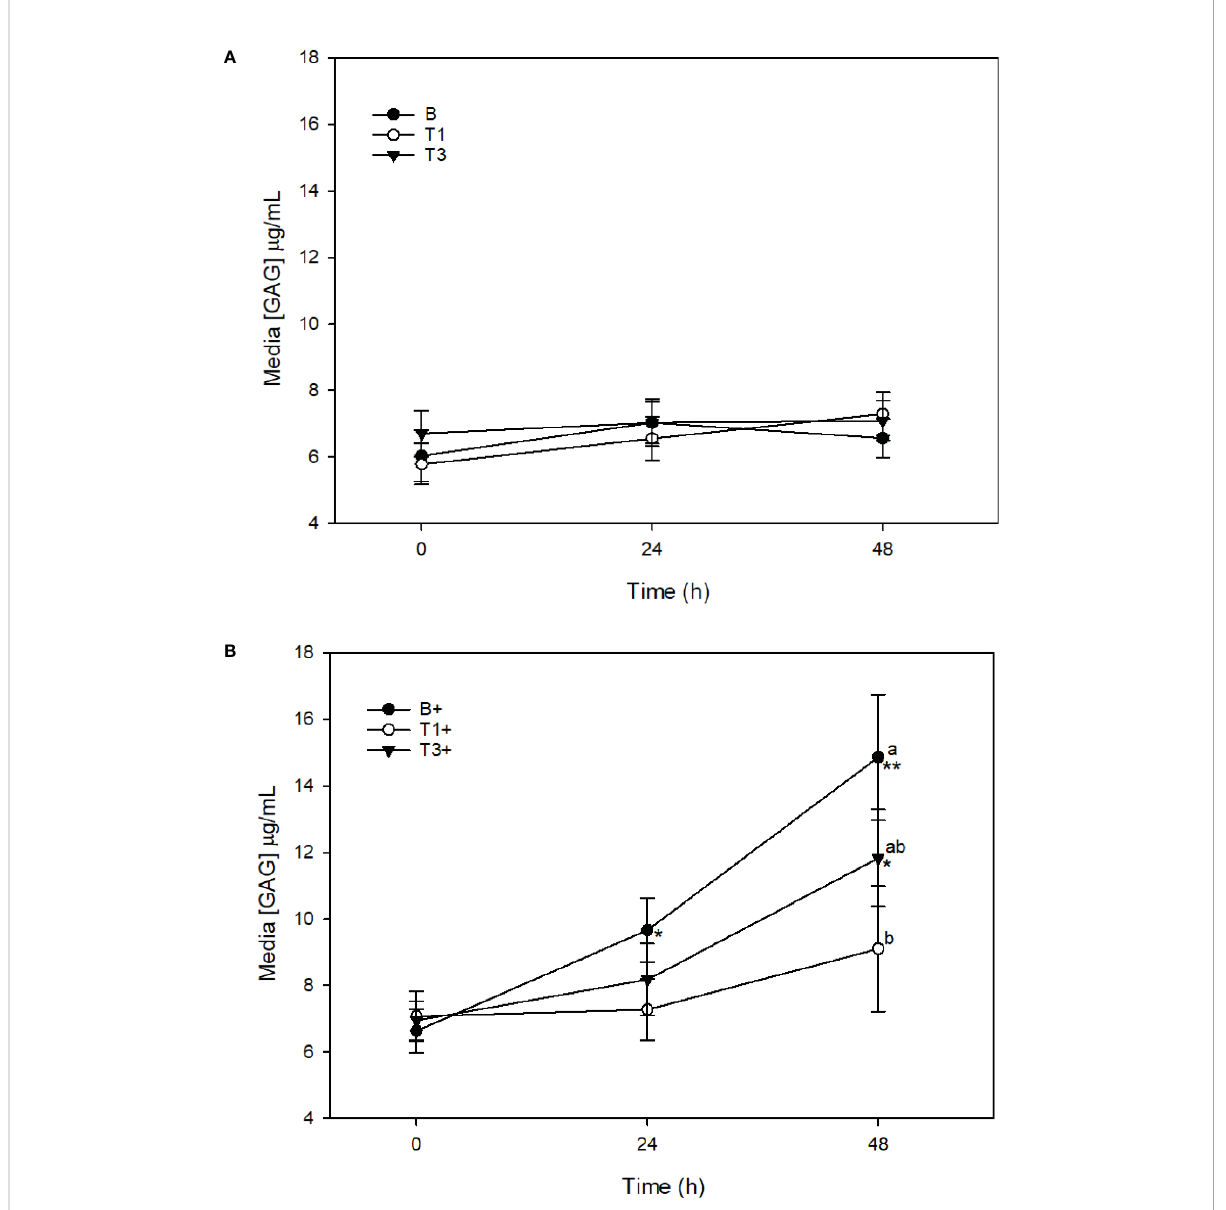
FIGURE 5 Media [GAG] (µg/mL) from explants cultured in basal media (B) or media conditioned with 5 (T1) or 15 (T3) µg/mL of Wheatgrass Extract. Expalnts were maintained without stimulation (A) or were stimulated with lipopolysaccharide (10 µg/mL;denoted as ‘ + ’ ) (B) . *denotes signi fi cant changefrom baseline within treatments. Letters denote signi fi cant difference between treatments at individual time